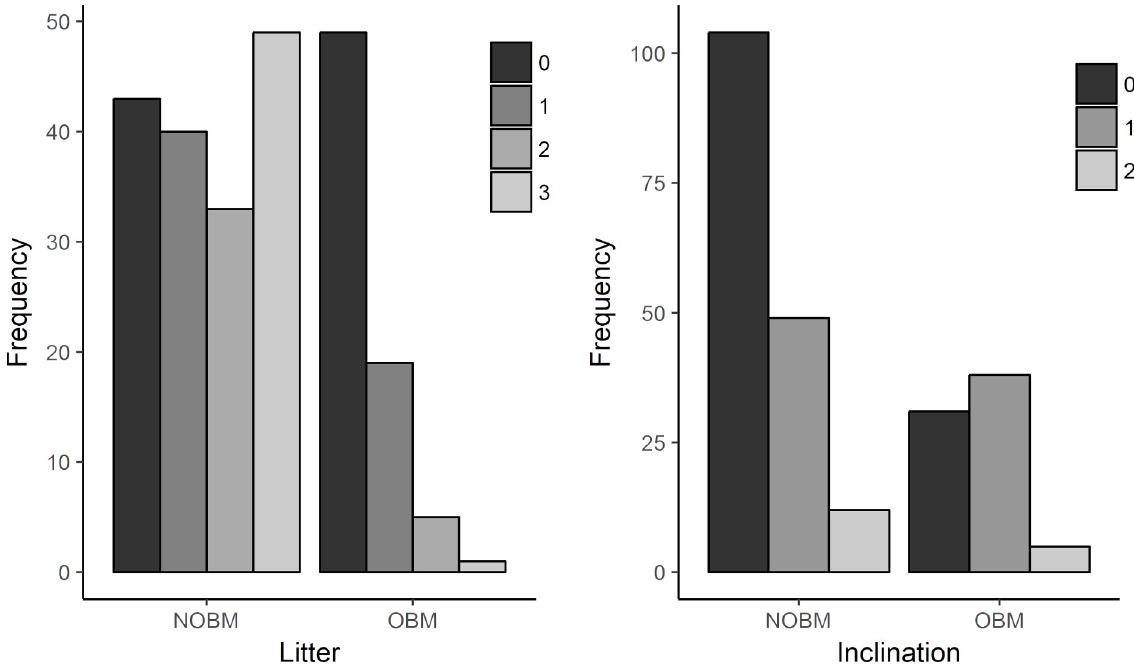
Fig 2. Differences between data on bromeliads not occupied by a male (NOBM) and occupied ones (OBM). (a) Differences in leaf litter. (b) Differences in inclination. Inset of figures show categories. Litter/ inclination: 0 = no litter/upright plants; 1 = small amount of litter/ slightly inclined plants; 2 = large amount of litter but not enough to prevent an individual of the anuran from passing through the central tank/ heavily inclined; 3 = very large amount of litter with no passage free through central tank/ it is not a category to “inclination”.